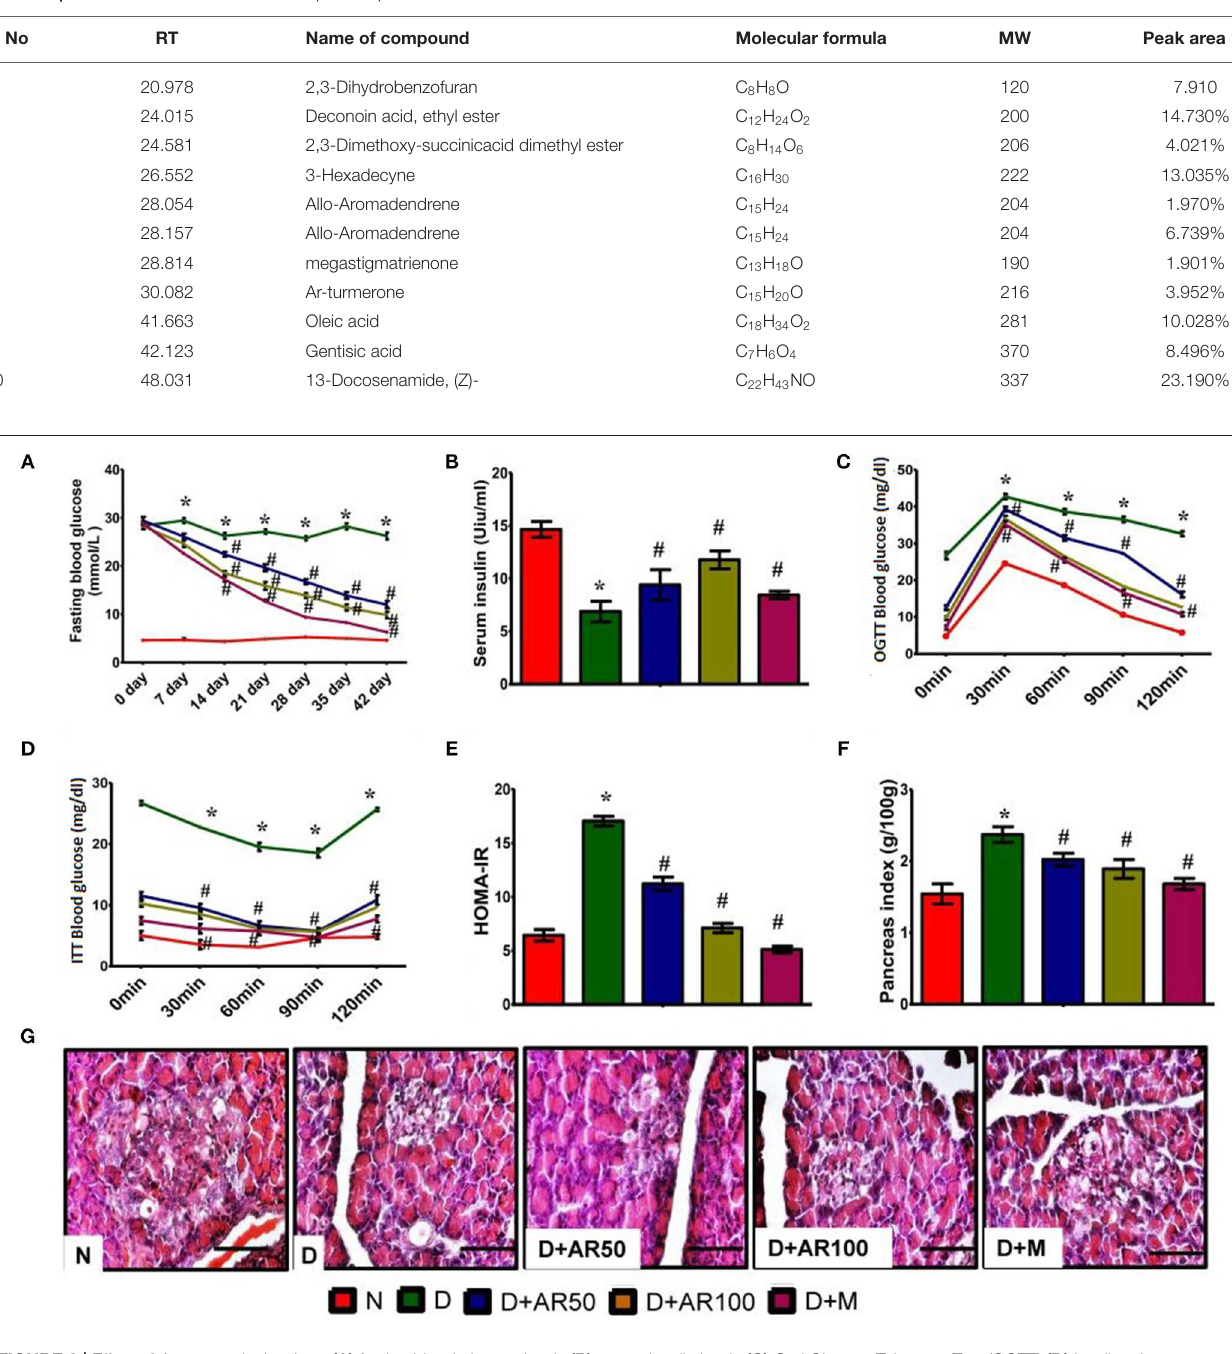
FIGURE 2 | Effect of Annona reticulata L on (A) fasting blood glucose levels (B) serum insulin levels (C) Oral Glucose Tolerance Test (OGTT) (D) insulin tolerance test (ITT) (E) HOMA-IR (F) pancreas index (G) pancreas histology. Each value is mean ± SD of six rats in each group.*significant compared to normal control group p < 0.01. # significant compared to diabetic group p <